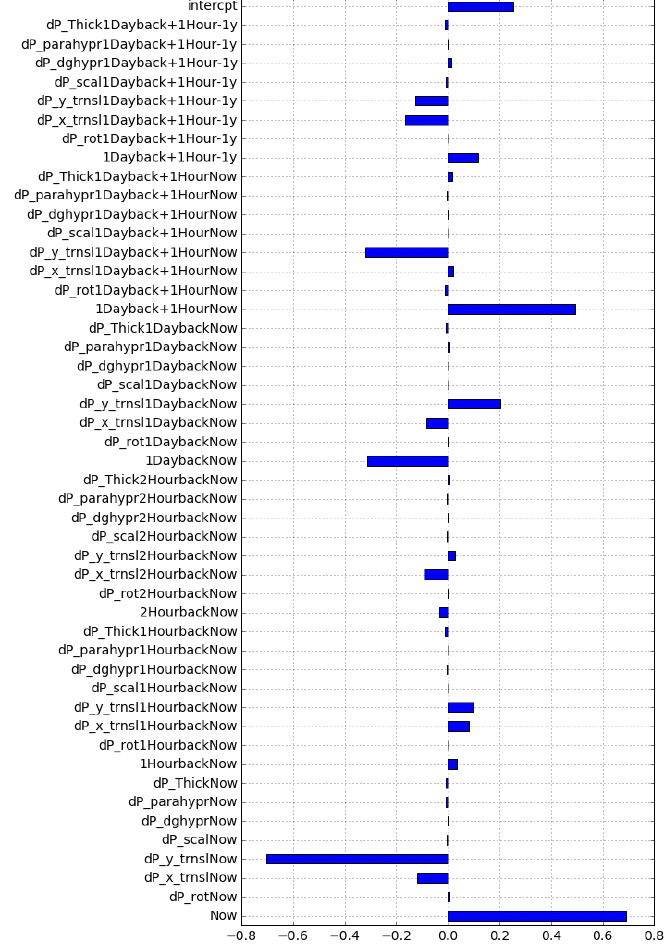
Figure 9. Weights for a one hour forecast at time “2016-02-21 13:15:00”. The term dP distTime , indicates ( P , α dist ) = (cid:126) T τ the tangent space ∂ s and the corresponding time dist ∂α dist